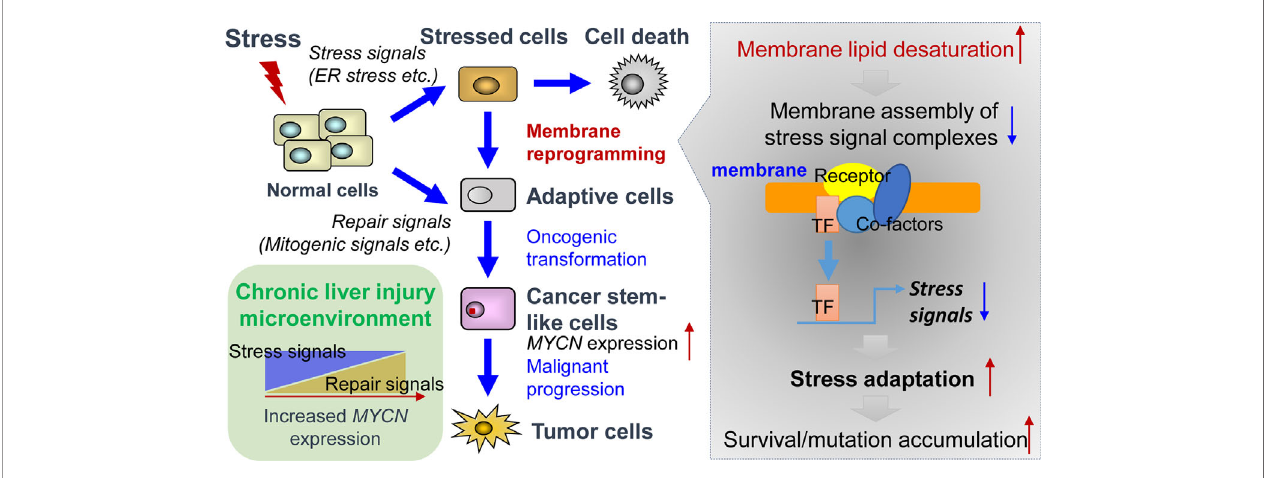
FIGURE 1 | Tissue repair and stress adaptation signal-based control of MYCN gene expression in the in fl ammatory microenvironment of liver cancer. Under lipid- rich in fl ammatory conditions, in fl ammatory cytokines-induced chronic injury leads to the activation of repair signals such as mitogenic signals resulting in compensatory proliferation, thereby triggering downstream MYCN gene expression. In contrast, lipid desaturation-mediated membrane reprogramming reduces or counteracts the formation of membrane assembly of stress signal complexes and enables the CSCs to survive and evade ER stress-induced apoptosis/ differentiation, which leads to the rescue of MYCN gene expression and initiates tumorigenesis by accumulation of mutations in long-living